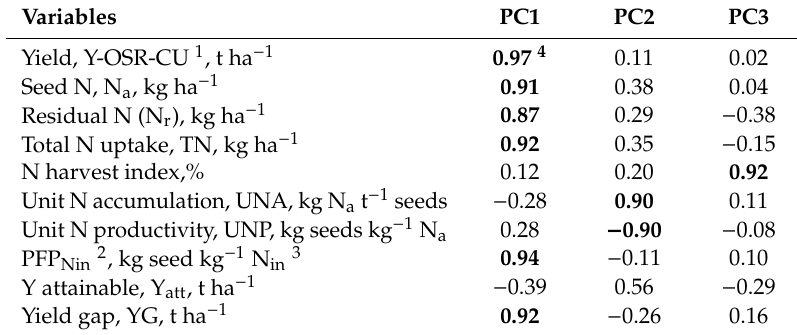
Table A1. Pearson’s correlation matrix between yield selected plant nitrogen variables and PCA factors for winter oilseed rape, n =